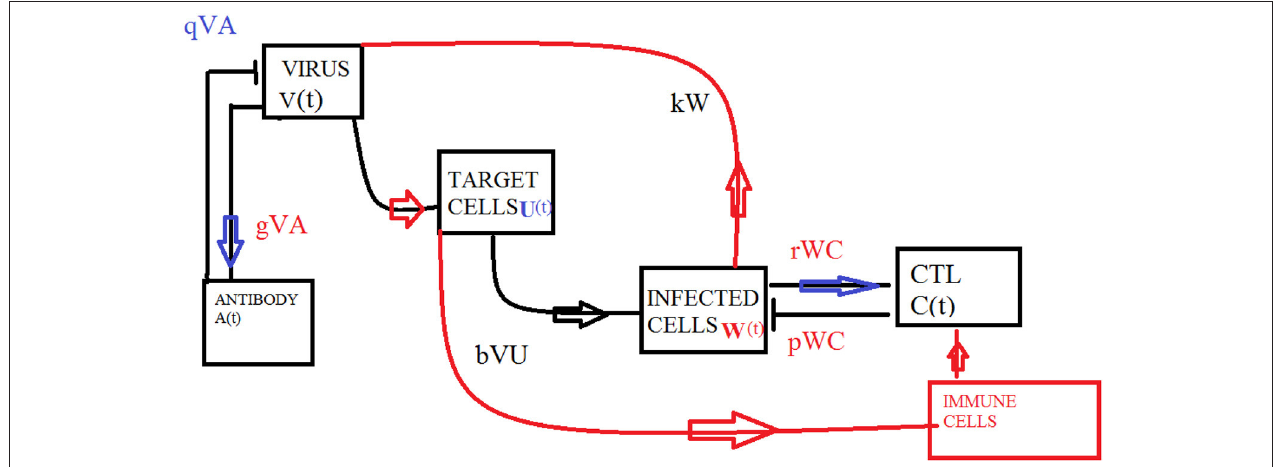
FIGURE 1 | Schematic of the model.